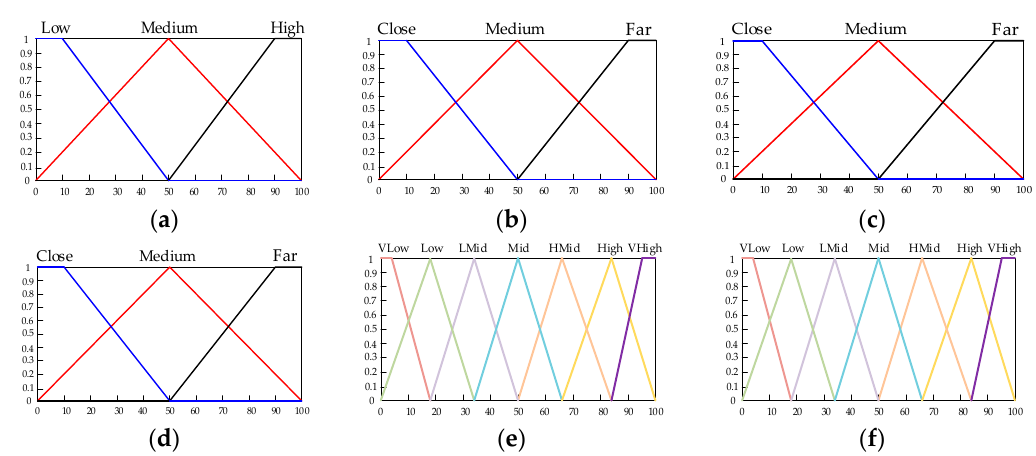
D ; ( c ) D ; ( e ) fuzzy D ; ( d ) iCH BS ij